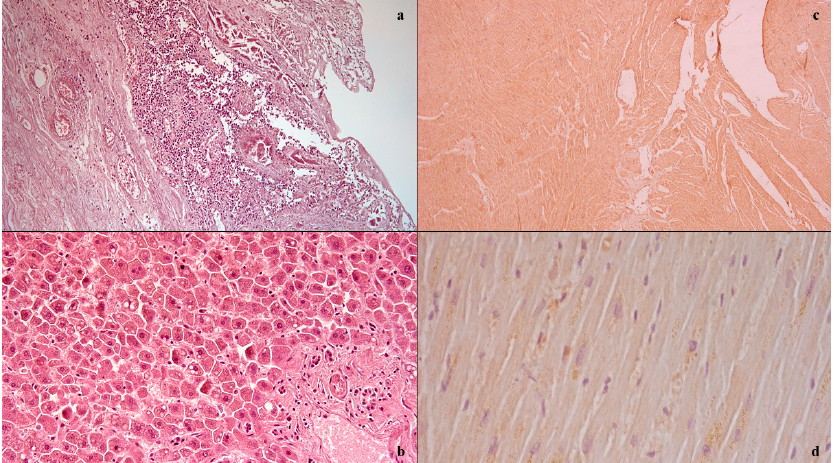
Figure 1. Histological investigation: mucosal and submucosal edema, and well-defined agglomerations of inflammatory cells in the context of the bowel wall ( a ); Councilman bodies of the liver ( b ); positive anti-IL15 ( c ) anti-TNF-alpha ( d ) antibody reactions on heart samples.